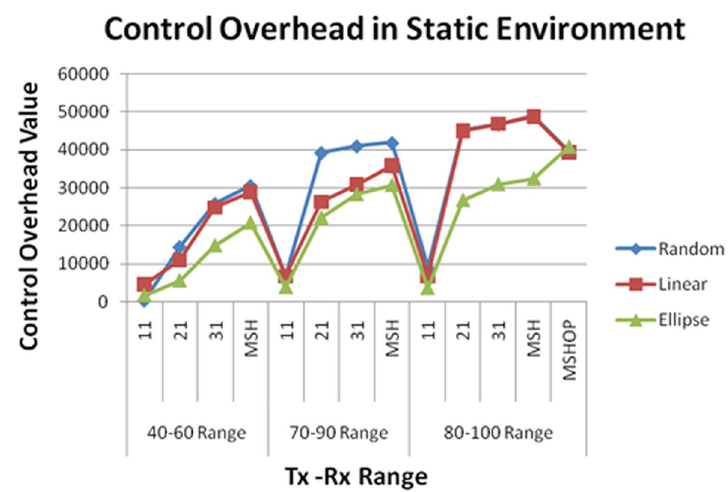
Fig. 27 Network overhead static environment